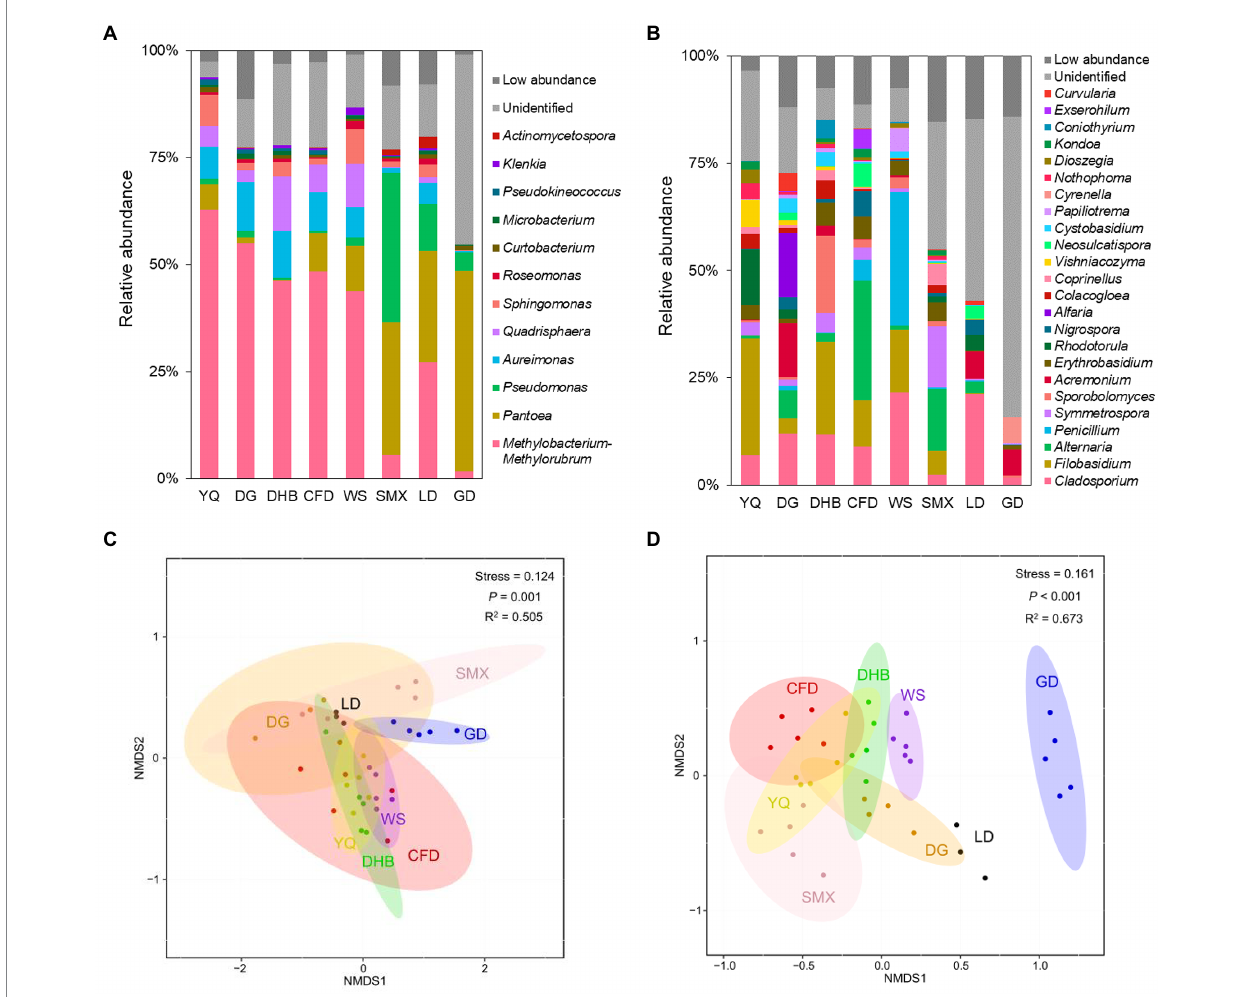
FIGURE 1 Relative abundance at genus level of bacterial taxa (A) and fungal taxa (B) in the foliar microbiome of eight genotypes of wild soybean. The total relative abundance of low-abundant bacteria and fungi that accounted for less than 0.5% is indicated as low abundance in darkgrey, and unidentified taxonomic groups are indicated in light grey. At each sampling site, there were three to five technical replicates sampled from three to five plants with the same genotype. Abbreviations for the sample name are depicted in Table S1. The NMDS analysis of bacterial (C) and fungal (D) community at genus level based on Bray-Curtis distances categorized by host